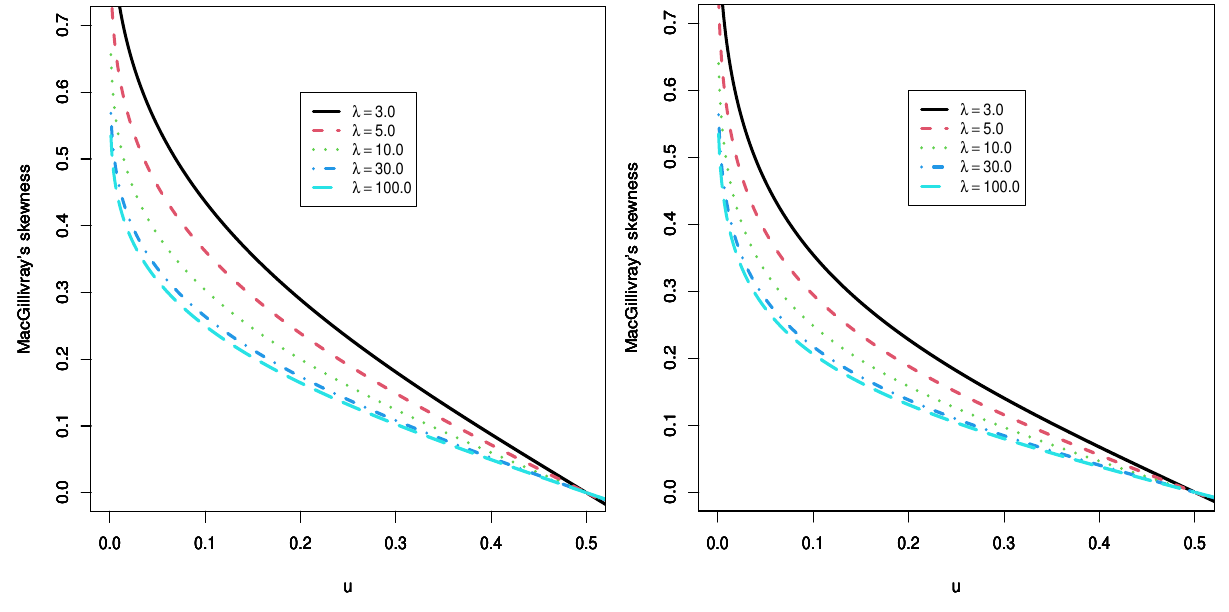
Figure 7. Plots of the MacGillivray’s skewness for FB distribution at p = 0.3 and n = 5,10.